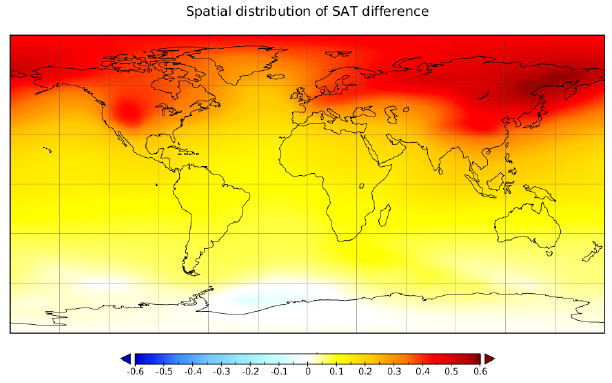
Fig. 5. Zonally-averaged annual cycle of the difference in temperature (EXT-CTL) over the Northern Hemisphere, during the 500th of the climate model simulation. On the abscissa, months are displayed from January to December according to their numerical order.